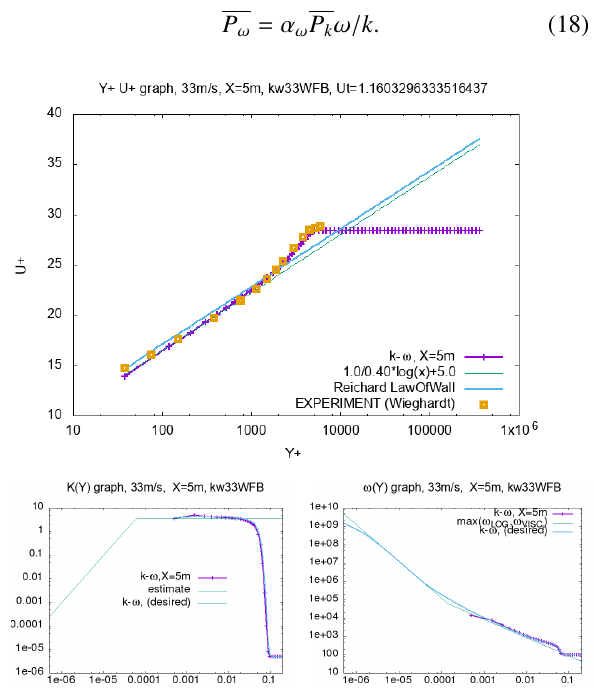
Fig. 3. CFD simulations, Launder-Spalding / Chieng-Launder methodology, height of the first cell 0.001m, regime U ∞ = 33 m.s − 1 . Graph for the U + (comparison with experimantal data), k ( Y ) ,ω ( Y ) in the vertical cut at x =